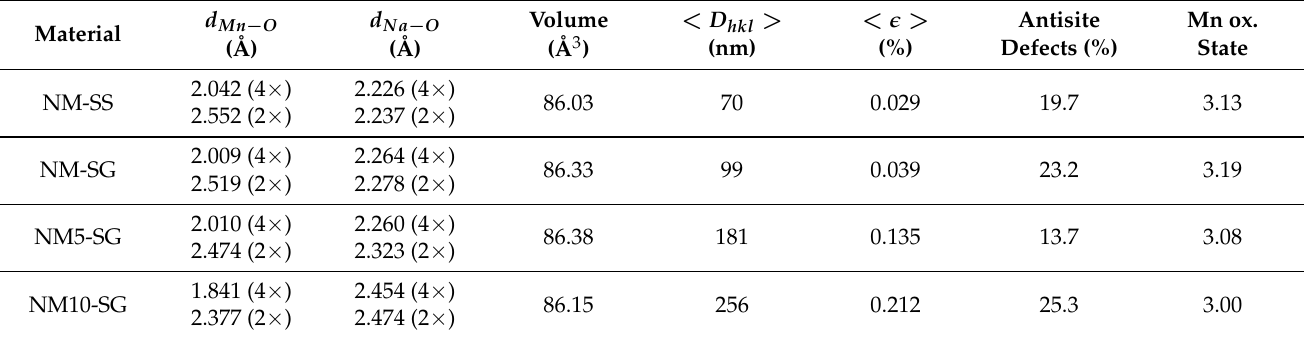
Table 4. Comparison between Mn-O and Na-O distances, unit cell volumes, sizes, strains, estimated antisite defects and Mn mean oxidation state in the four